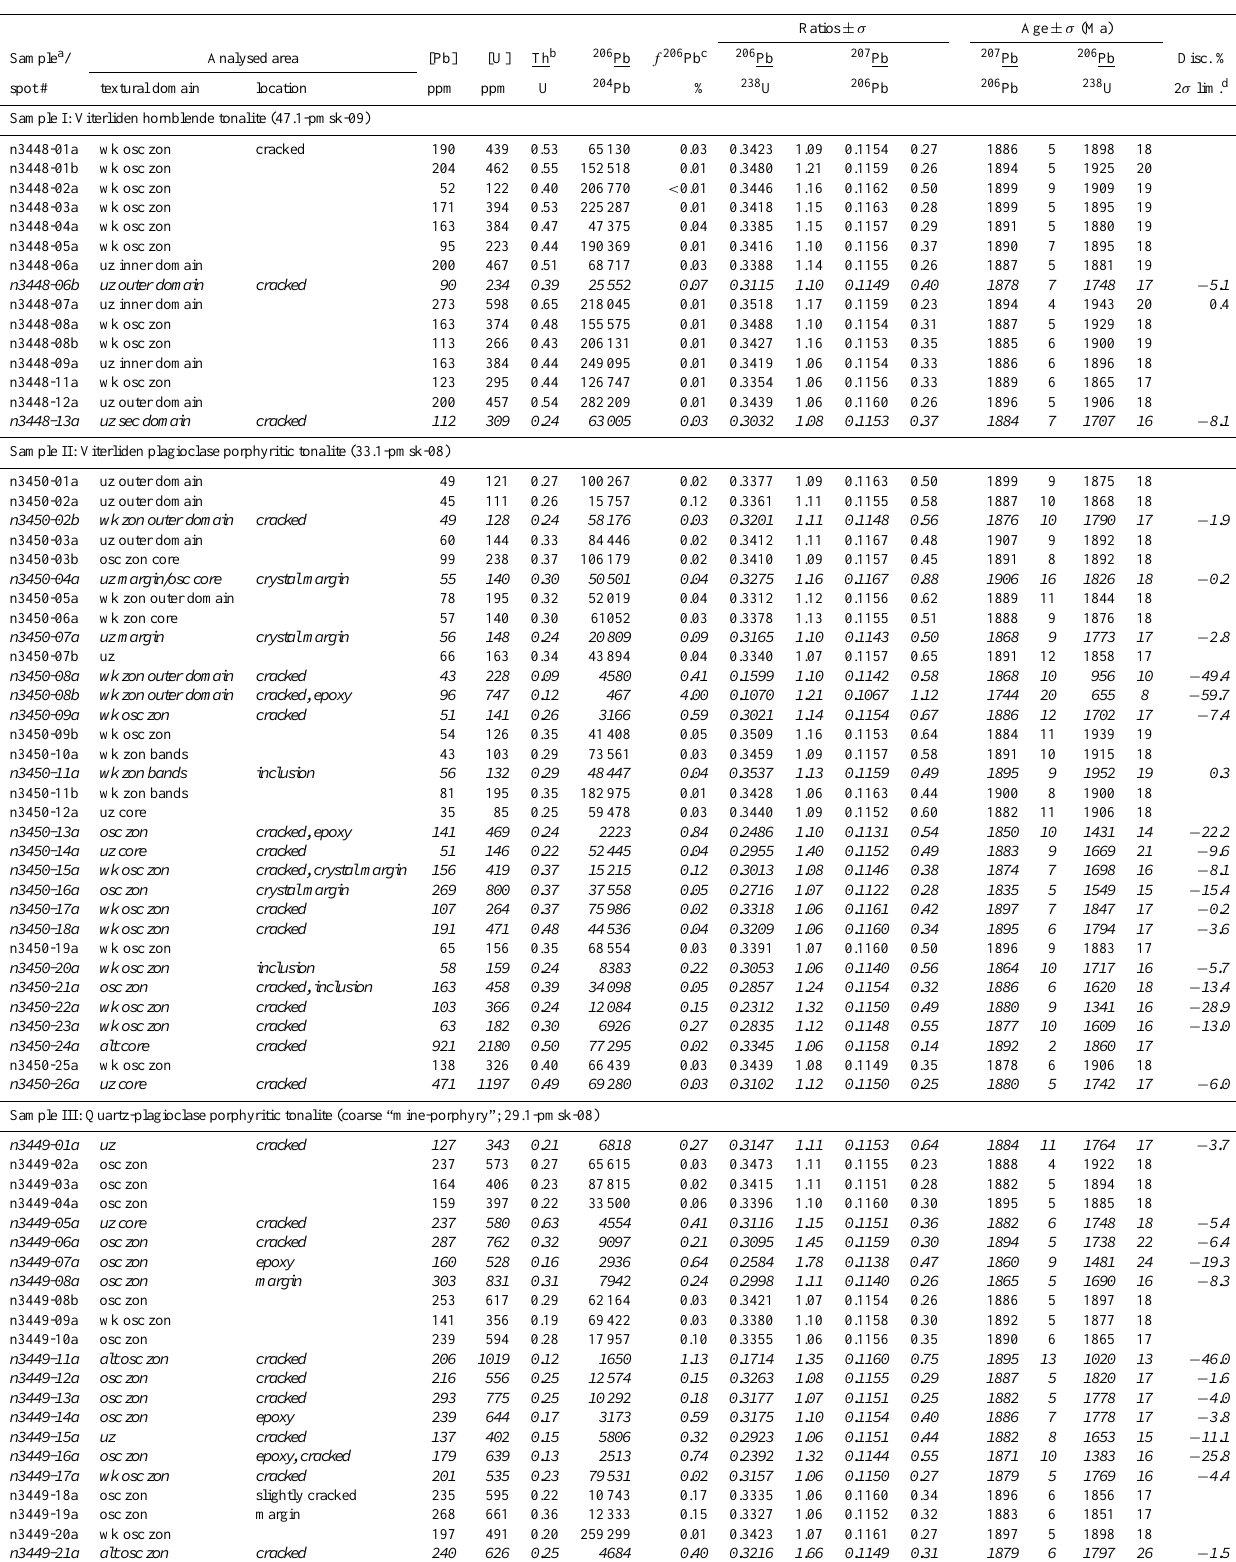
Table 1. SIMS U-Th-Pb zircon data from the Viterliden meta-igneous rocks. Zircon ion microprobe data for the intrusive and volcanic rocks dated in this